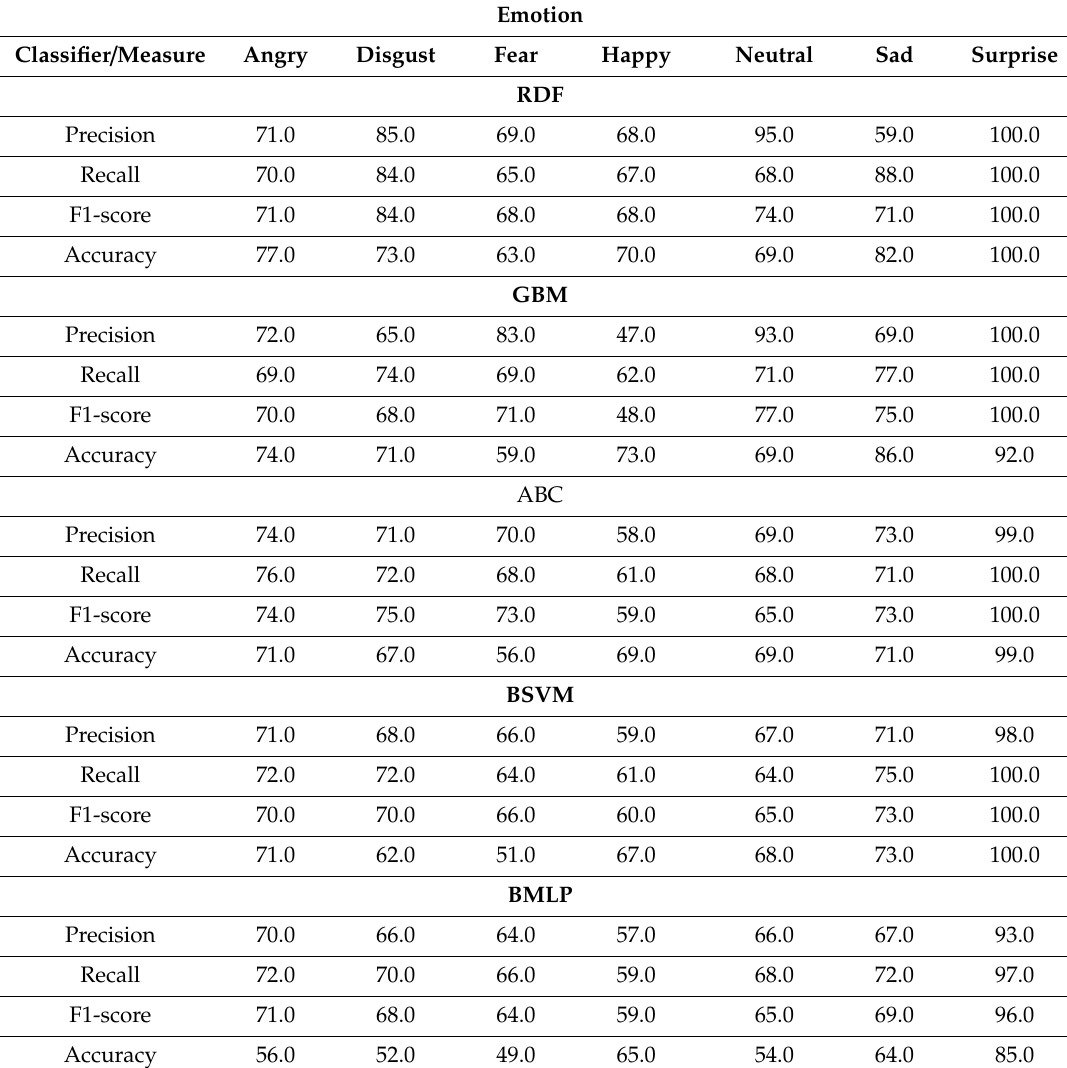
Table 9. Percentage precision, recall and F1-score and accuracy on SAVEE